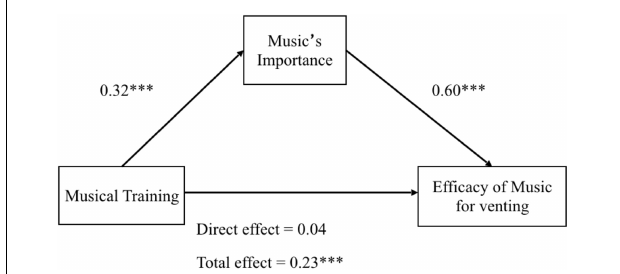
FIGURE 1 | Model of the effect of musical training on the perceived efficacy of music for venting of negative emotions, mediated by music’s importance. p < 0.001 ∗∗∗